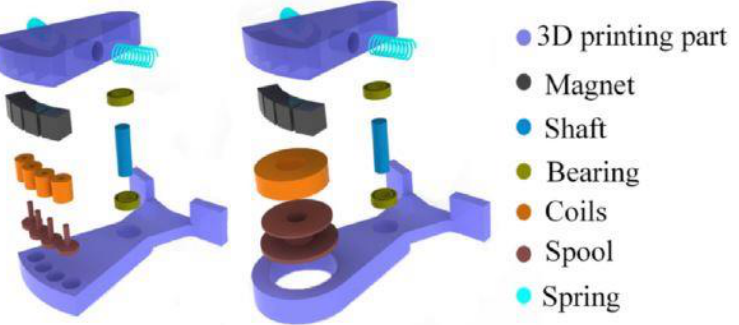
Figure 5. Pendulum electromagnetic energy harvester based on Halbach array [56]. Reprinted with permission from Ref. [56]. Copyright 2021, Elsevier.